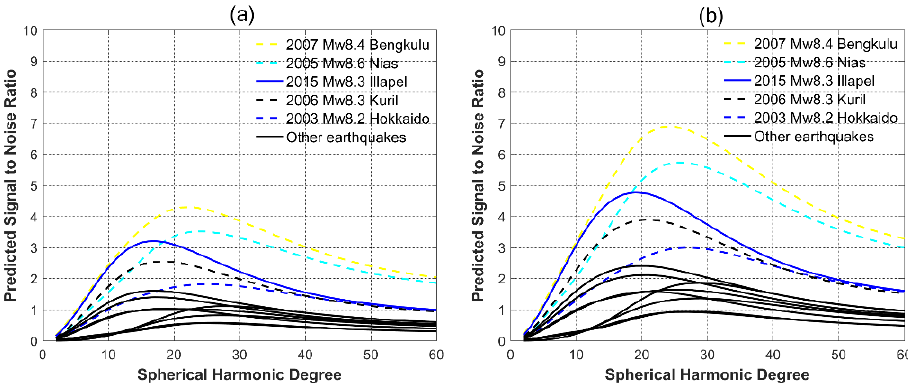
Figure 6. Ratio of the model-predicted coseismic gravity changes to cumulative stack errors of GRACE( a )/GFO( b ) in spectral domain, respectively.